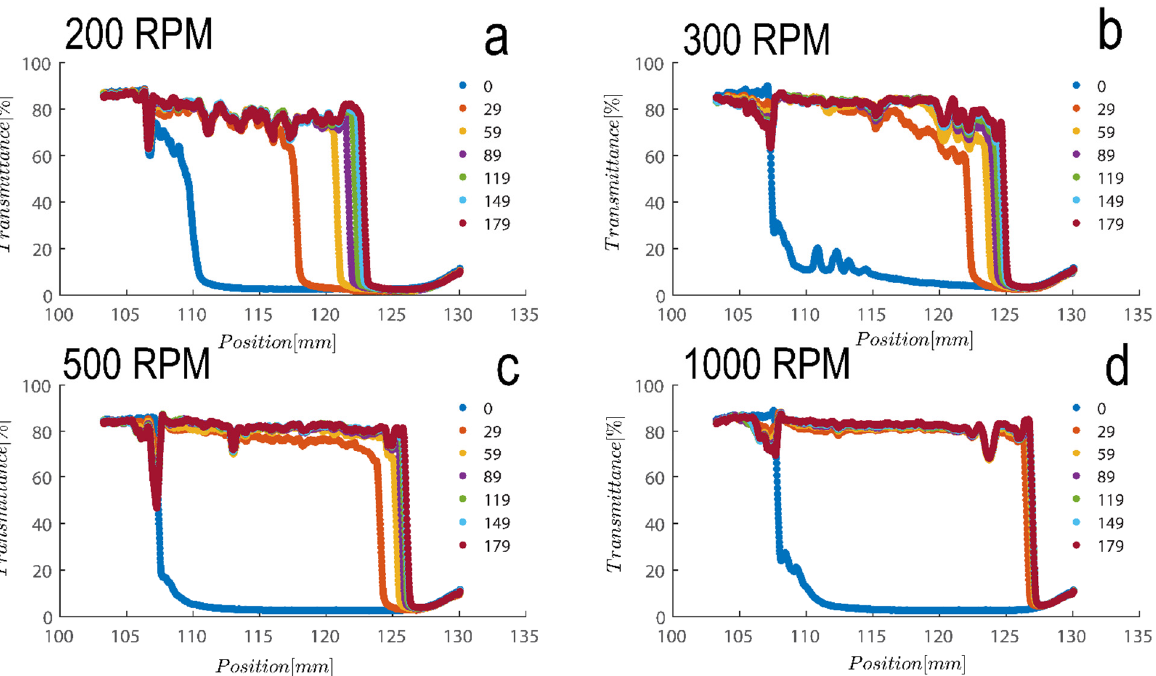
Figure 5. Transmission profiles obtained during centrifugation of a kaolinite sample (Sigma I) with 7wt% at ( a ) 200, ( b ) 300, ( c ) 500 and ( d ) 1000 rpm (corresponding to a centrifugal acceleration of 5.1, 11.3, 31.5, and 126× g , based on middle point of 115 mm). Volume of suspension added into the cells is 0.4 mL. Position of illuminated cell varies between 103–130 nm; the low transmission at the end of the cell demonstrates that particles are accumulating there.